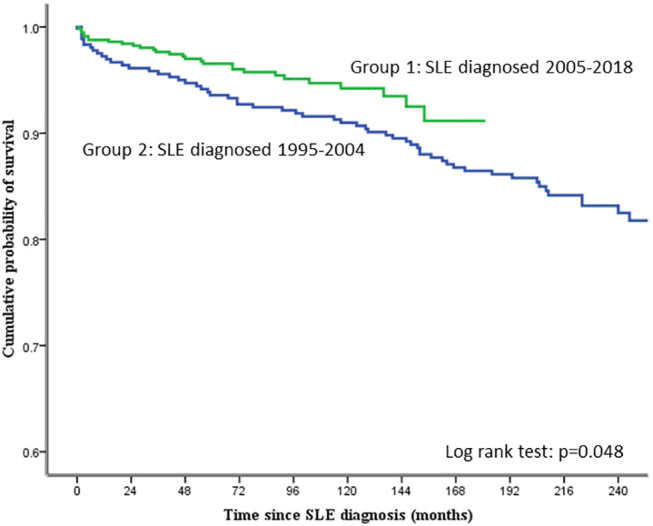
Cumulative probability of survival in the SLE patients studied.